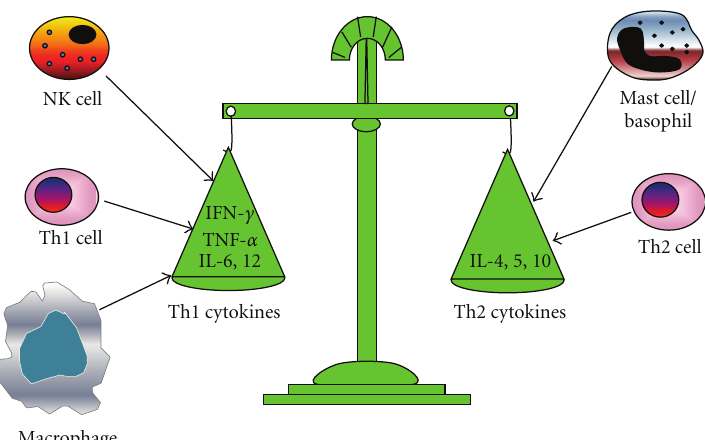
Figure 3: The T helper (Th)1/Th2 balance. Th1 cytokines, characterized by the production of interferon (IFN)- γ and interleukin (IL)-6, are involved in cellular immunity and immunoglobulin class switching to the IgG2a isotype, whereas Th2 cytokines, characterized by IL-4 and IL-10, are mainly associated with humoral immunity and immunoglobulin class switching to IgG1 and IgE. Th1 cells are the primary Th1 cytokine producing cells. Besides, natural killer (NK) cells and macrophage also contribute to the production of Th1 cytokines. Similarly, Th2 cells produce the most Th2 cytokines in addition to mast cells and basophils. TNF- α denotes tumor necrosis factor